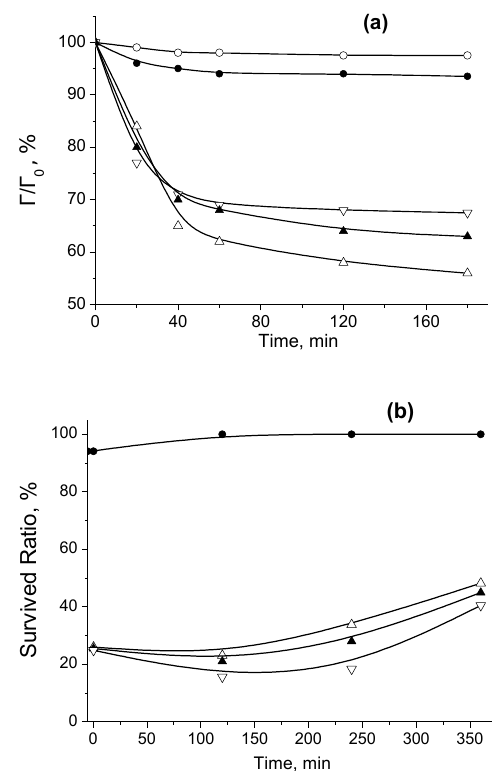
Figure 5. ( a ) Degradation kinetics of Rhodamine 6G at the glass substrate ( ○ ), TiO 2 (●), TiO 2 /MoO 3 (Δ), TiO 2 /WO 3 ( ▲) , and TiO 2 /V 2 O 5 ( ) photocatalysts under dark conditions after the samples were exposed to UV light for 10 min at 298 K. Γ/Γ 0 is a ratio between measured (Γ) and initial (Γ 0 ) concentration of Rhodamine 6G. ( b ) The time dependence of the s urvival ratio for Escherichia coli bacteria at the surface of TiO 2 (●), TiO 2 /MoO 3 (Δ), TiO 2 /WO 3 ( ▲ ), andTiO 2 /V 2 O 5 ( ) samples exposed to UV light for 10 min and then put in the dark for different times.